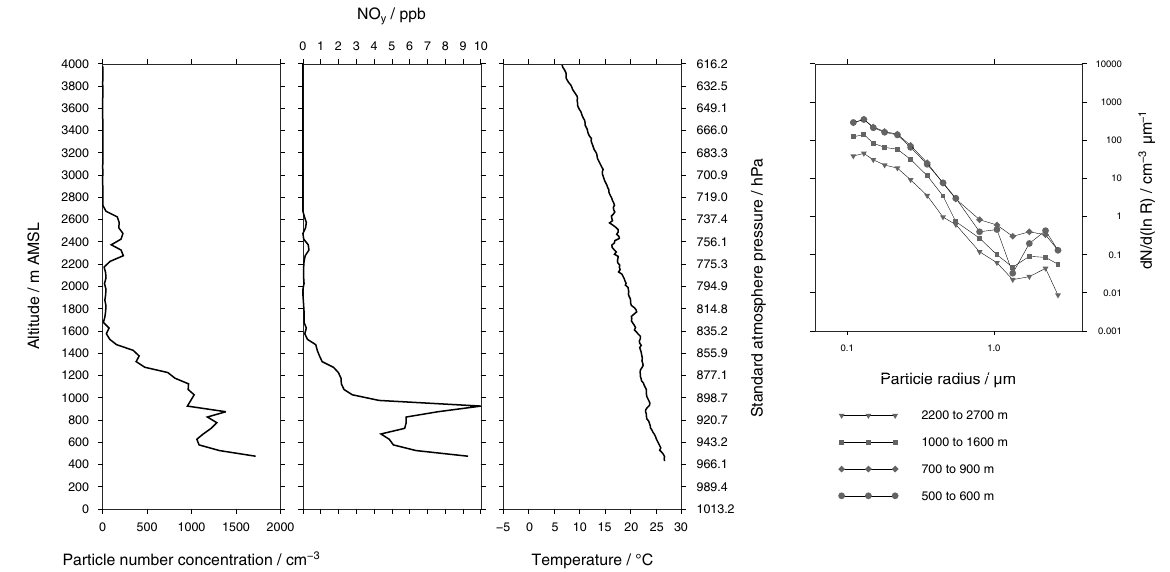
Figure 2. Vertical profiles of particle number concentration, in situ NO y , and temperature on 11 August 2007 between 11:01 and 11:40UTC over the coastal town of Richards Bay. Average particle size spectra for altitude intervals of interest are